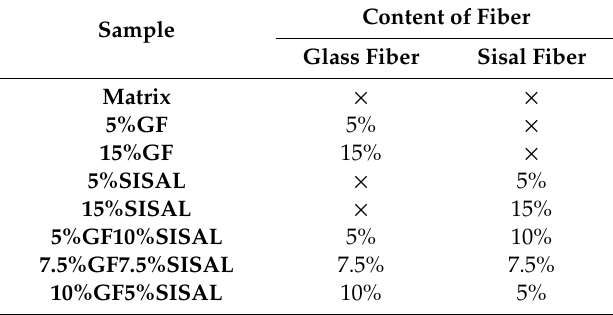
Figure 1. Proposed course of the main reaction occurring as a result of liquefaction of cellulose biomass.